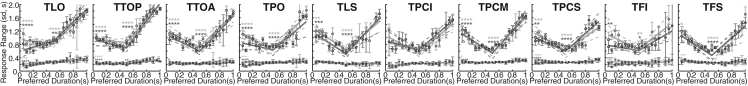
Changes in Response Function Extent within Timing MapsIn data grouped across subjects, response function extent systematically increased with preferred duration in posterior maps (and along the minor axis) and with distance from the middle of the presented range in the major axis of anterior maps. Left and middle stars show the significance of increase with preferred duration and distance from the middle of the presented range, respectively. Large and small stars show the significance of major and minor extent increases, respectively. ∗p < 0.05, ∗∗p < 0.01, ∗∗∗p < 0.001, ∗∗∗∗p < 0.0001. Points show bin mean values; error bars show SEs.